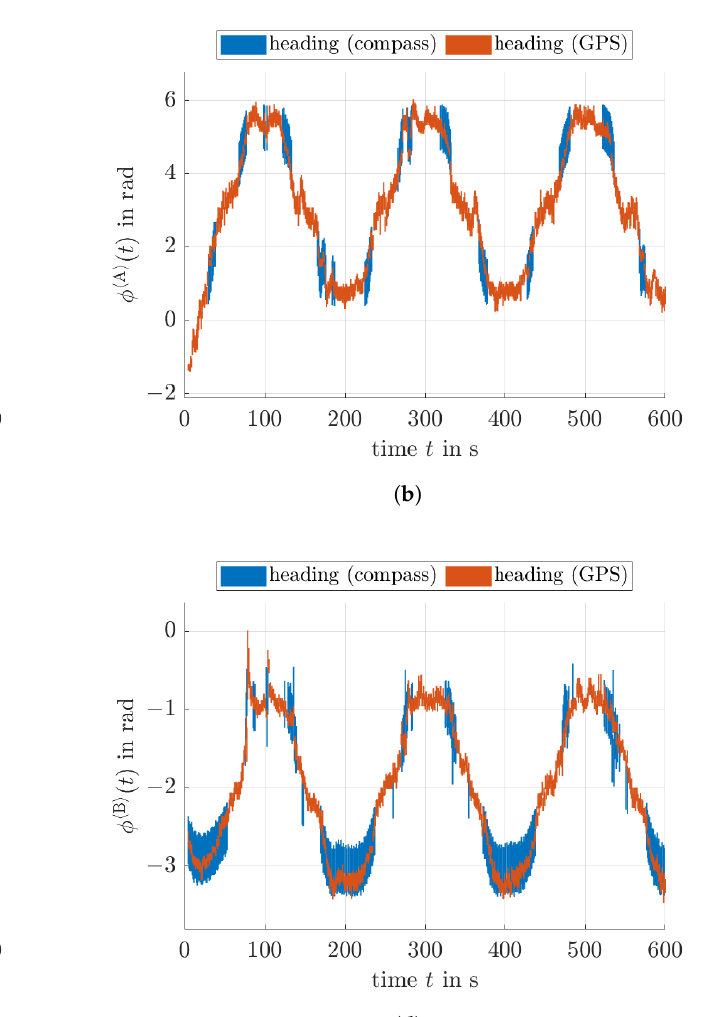
Figure 5. Interval-based measurement error identification for the heading of both DDboats. ( a ) Constant error bounds for the heading measurement of DDboat A. ( b ) Time-varying error bounds for the heading measurement of DDboat A. ( c ) Constant error bounds for the heading measurement of DDboat B. ( d ) Time-varying error bounds for the heading measurement of DDboat